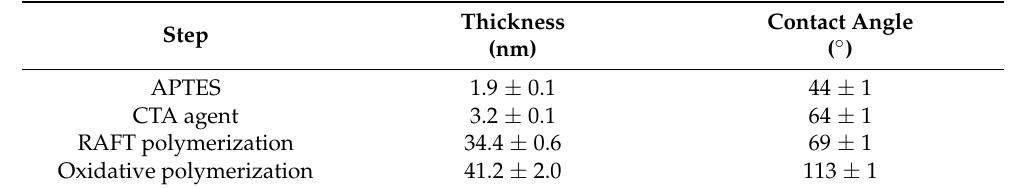
Table 1. Thickness, determined by ellipsometry, and water contact angles of organic layers on silica substrate during the formation of the initiator layer and subsequent RAFT polymerization leading to